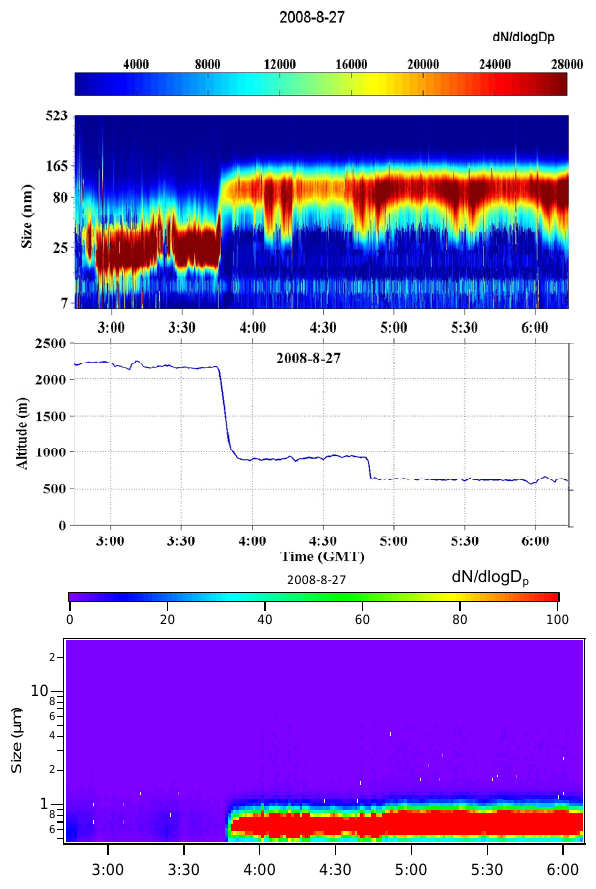
Fig. 8 Variation of size distributions for fine (5.6-560 nm) and coarse (0.47-30 μ m) particles with Fig. 8. Variation in size distribution for fine (5.6–560nm) and altitudes at different heights on Aug. 27 flight coarse (0.47–30µm) particles with altitude for the 27 August flight.